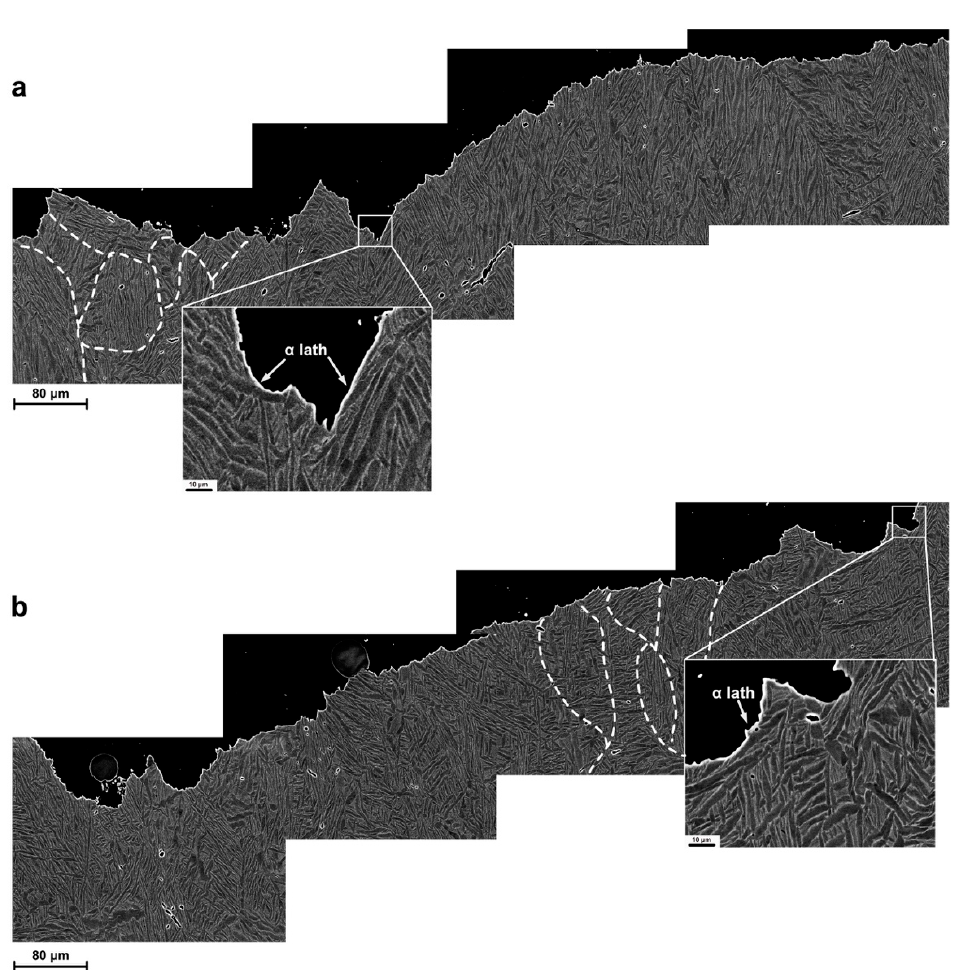
Figure 12. The fracture surface cross-section characterization of SLMed Ti-64 annealed at 950 °C in two directions: ( a ) horizontal direction; ( b ) vertical direction. The prior- β grain boundaries were traced by white dot lines.